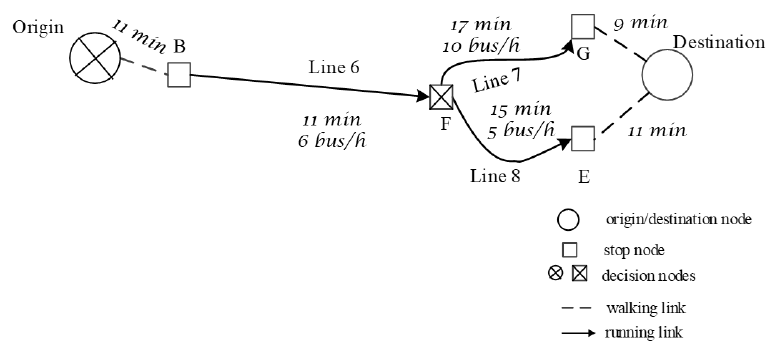
Figure 3. Optimal hyperpath for the MDPm with the state–action tree in Figure 2.